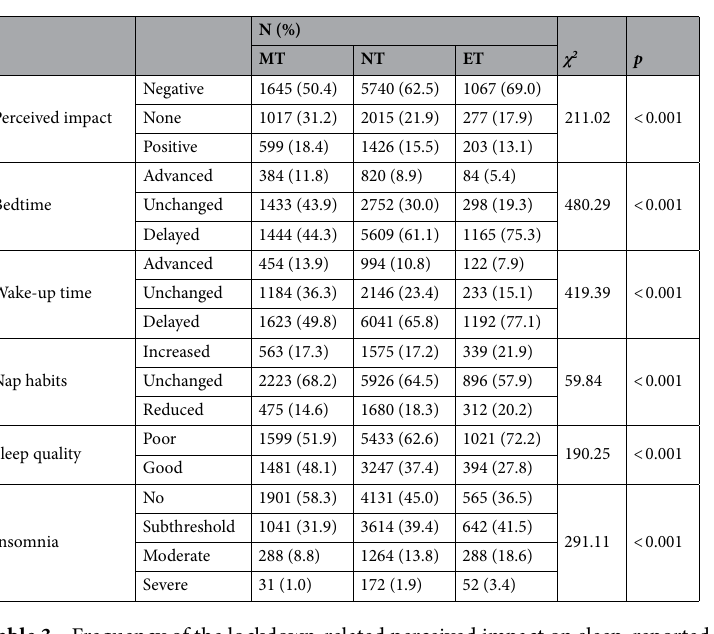
Table 3. Frequency of the lockdown-related perceived impact on sleep, reported changes of bedtime, wake-up time and nap habits, and prevalence of poor sleepers and clinical insomnia conditions within the three chronotype groups (MT, NT, ET). Chi-square test results are also reported ( χ 2 and p ). MT Morning-type, NT Neither-type, ET Evening-type.